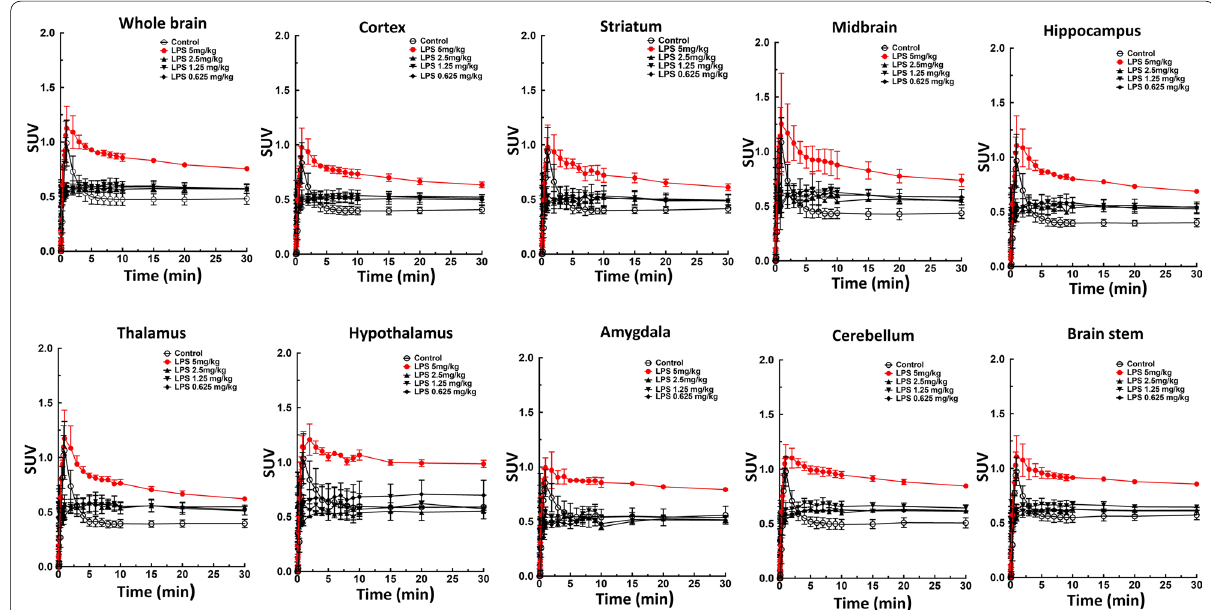
Figure. 6: Time‑activity curves for [ 18 F]FEPPA in different regions of the brain based on PET/MRI imaging 24 h after injection of various doses of LPS. There was no significant difference in brain [ 18 F]FEPPA uptake when the dose of LPS was ≦ 2.5 mg/kg, but significantly higher uptake was observed at 5 mg/kg LPS. Data are mean SEM of 6–8 mice per group ±